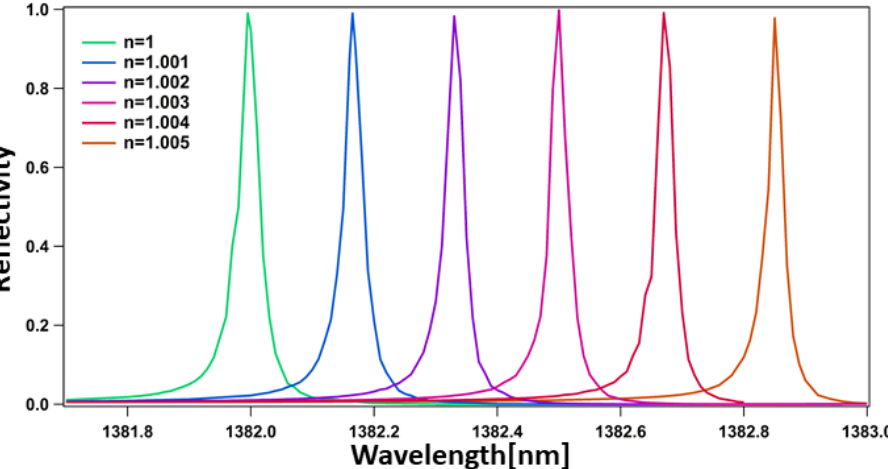
Figure 3. Traditional refractive index sensing mechanism based on the resonant peak shift for different values of n . The peak shift ( ∆ λ res ) linearly increases with the environment refractive index change ( ∆ n env ). The graph is obtained for a double NC array without spokes and radius of 250 nm, height of 274 nm, gap of 15 nm and periodicity of 850